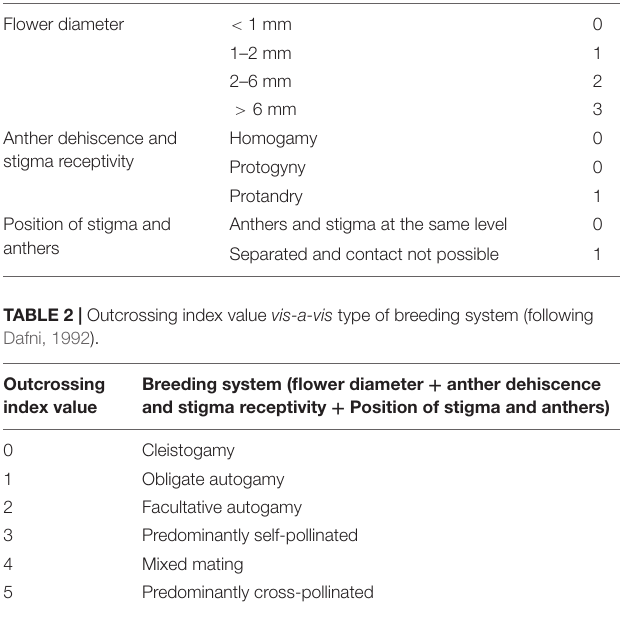
TABLE 1 | Observations of different floral parameters to determine outcrossing index of Rheum webbianum (following Dafni, 1992). Observation